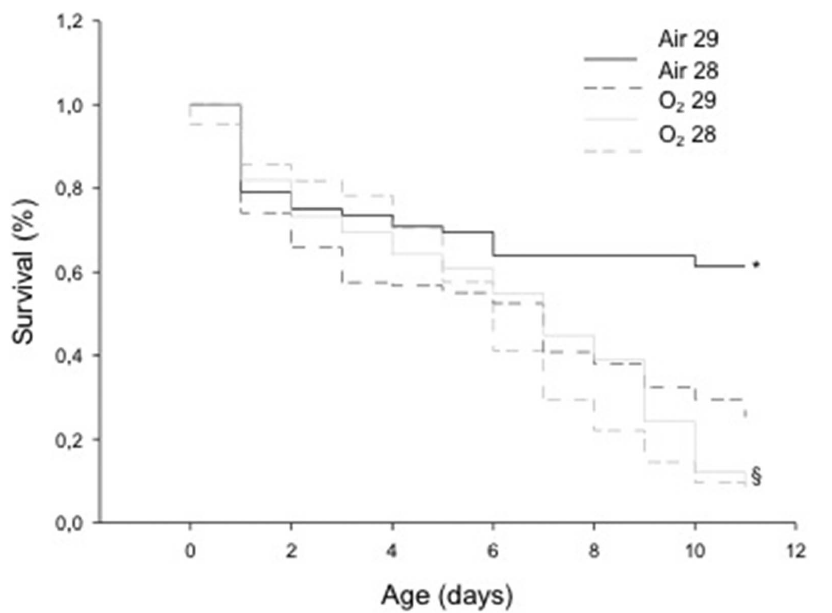
Figure 1. Kaplan-Meier survival curves – A comparison between the groups ‘room air’ and ‘oxygen’ is shown with animals born at 28 (dashed lines) and 29 days of gestation (solid lines). A higher survival rate was observed in both Air Groups (*, p , 0.05 vs Oxygen Groups) and a higher survival rate among O2 29 animals vs O2 28 Group ( 1 , p , 0.05)